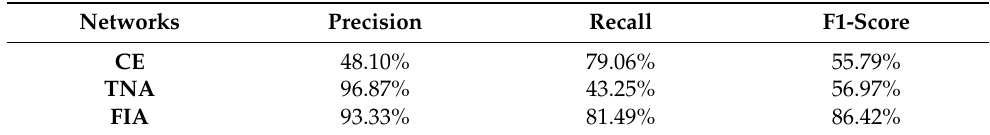
Table 2. Precision, recall and F1-scores for multi-stage transfer learning using DeepLabv3+ architec-